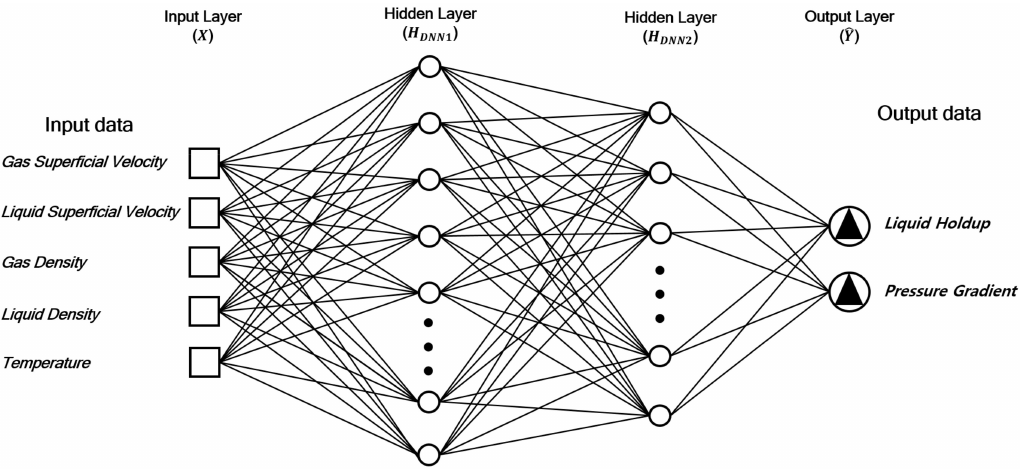
Figure 2. DNN design to estimate the liquid holdup and pressure gradient. One input layer ( X ), one output layer ( ˆ Y ), and two hidden layers ( H DNN1 and H DNN2 ) were